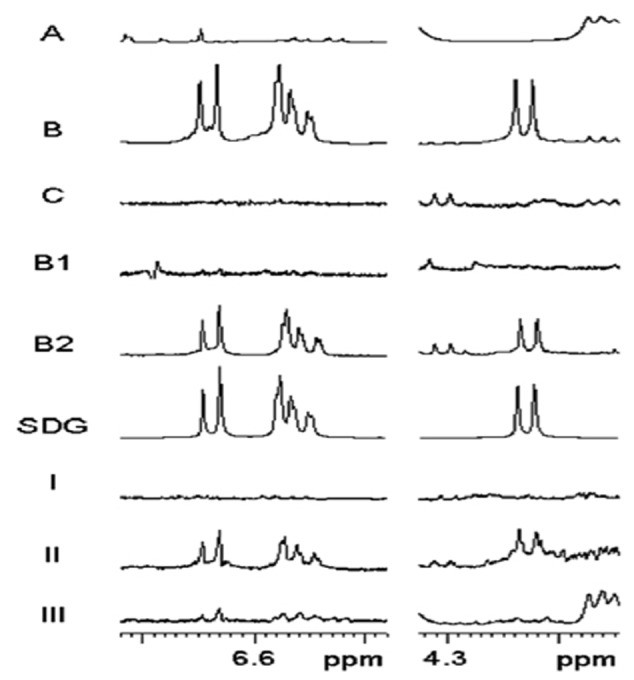
1H NMR spectra (500 MHz, MeOH-d4) of hydrolyzed material from different cell types of flaxseed coats.
1H NMR spectra (A,B,C,B1,B2) were obtained from mature seed samples. (SDG) 1H NMR spectrum of secoisolariciresinol diglucoside. 1H NMR spectra (I,II,III) were obtained from 25 DAF seed samples. For details of sample preparation, see Figures 1 and 2. Partial 1H NMR spectra show characteristic SDG signals of the aromatic protons (H-5/5′: δ6.64; H-2/2′: 6.58; H-6/6′: 6.56) and the doublet of the proton at the anomeric center of glucose (H-1″/1‴: δ 4.23). DAF, days after flowering.